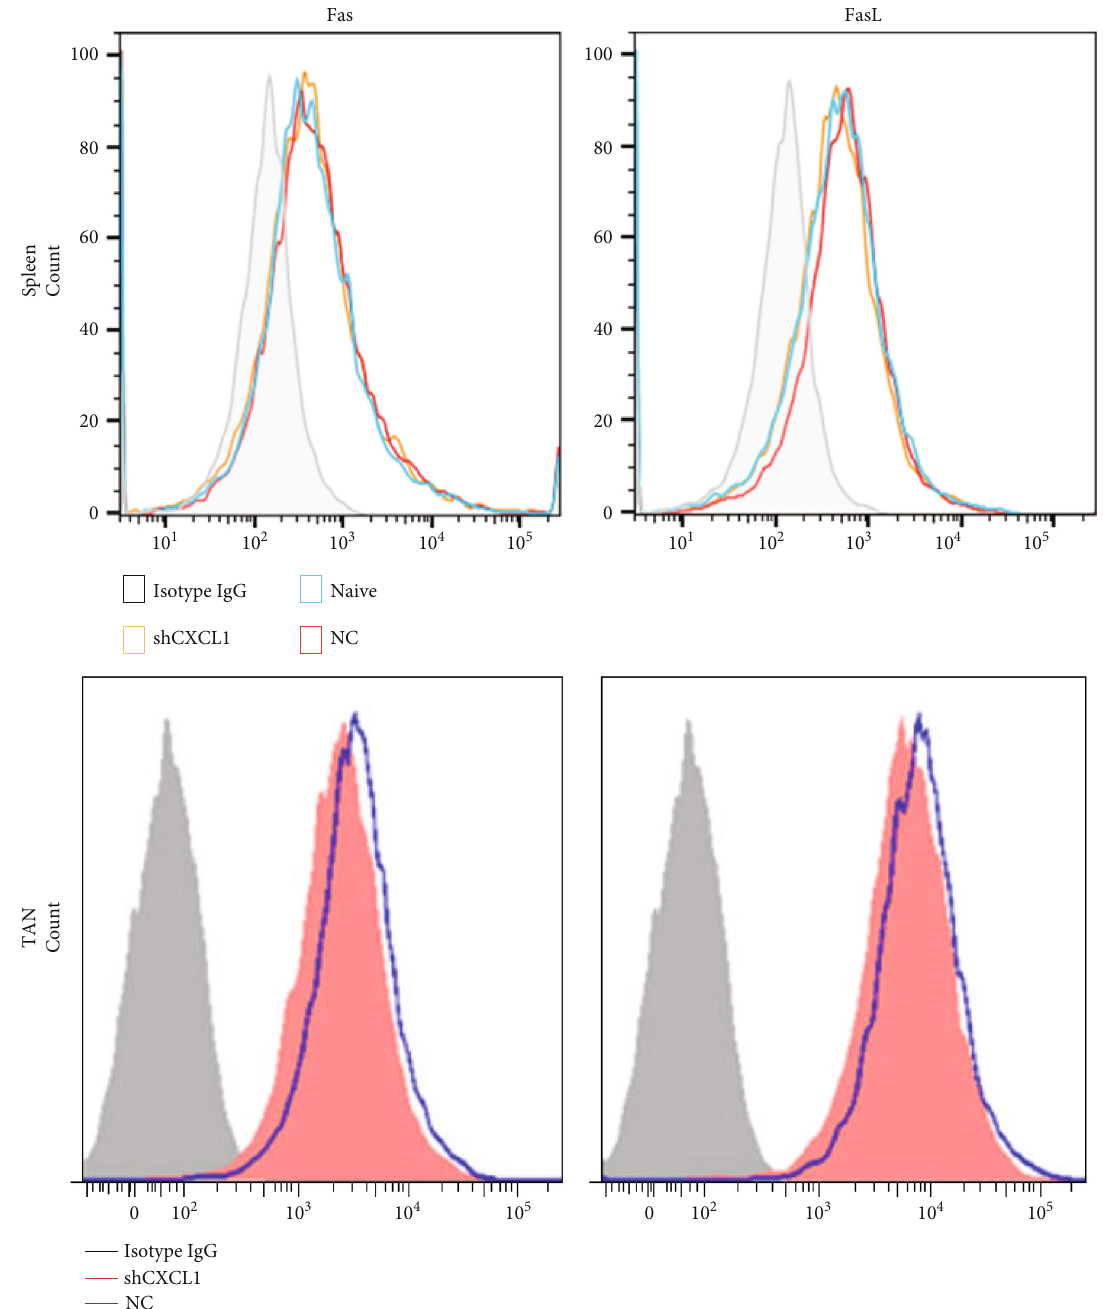
Figure 4: Tumor-in fi ltrating neutrophils in tumor inhibit T cell proliferation. (c) Fas/FasL expression on splenic CD11b + Ly6G + neutrophils or TANs from 3LL/NC bearing mice, 3LL/shCXCL1 bearing, or naïve mice were analyzed by cytometric